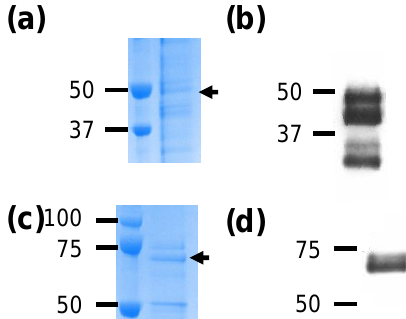
Figure 1. Expression and characterisation of VirB9-1 and VirB10. Purified proteins were loaded at 6 µg/well for Coomassie Blue stain ( a , c ), and 1.2 µg/well for Western blot ( b , d ); ( a ) VirB9-1 purified protein; ( b ) Western hybridisation of VirB9-1, probed with anti-VirB9-1 mAb (133/248.14.1.28); ( c ) VirB10 purified protein; ( d ) Western hybridisation of VirB10, probed with an anti-VirB10 mAb (138/481.3.9). Sizes shown in kDa. Full gel image of ( b ) and ( d ) is shown in Figure S2.